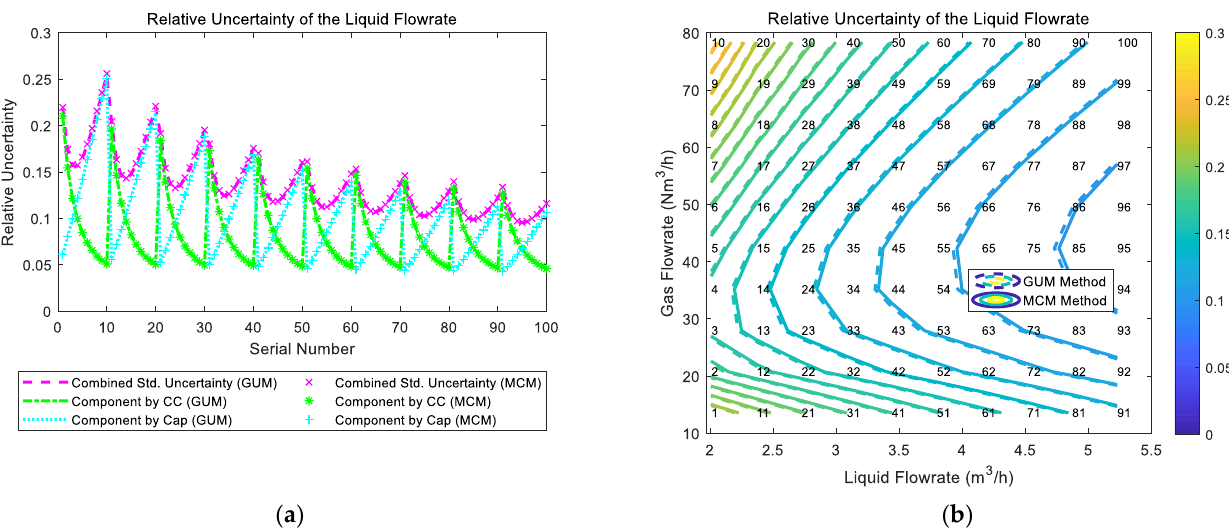
Figure 6. The composition and distribution of the relative uncertainty of the liquid flowrate of the “Cap + CC” method: ( a ) composition diagram; ( b ) distribution diagram. (Each contour line denotes an increment of uncertainty of 0.01. More information about the composition and distribution can be found in Section 2.4.1).